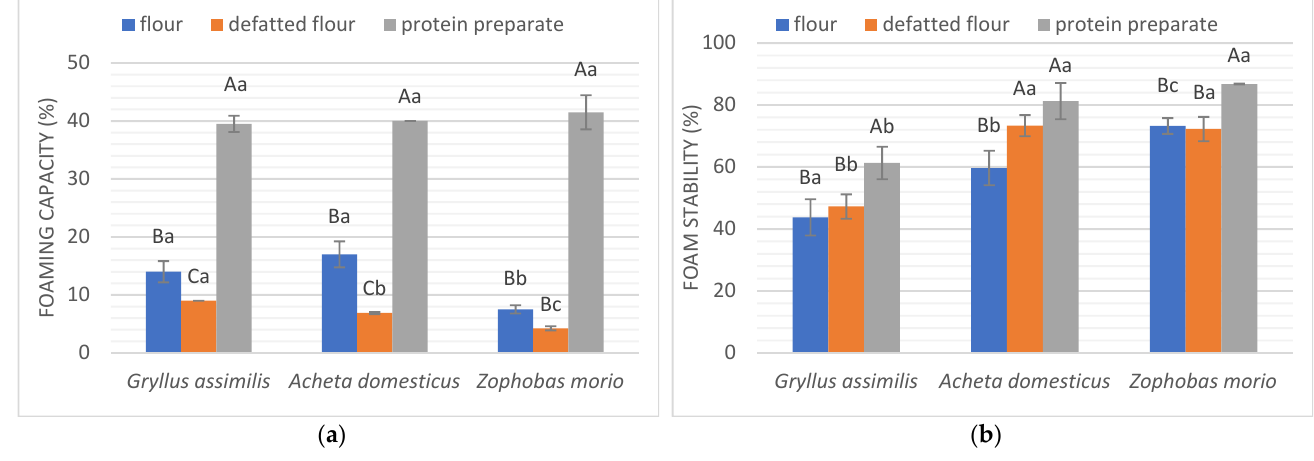
Figure 3. Foaming properties of studied insect forms. ( a ) Foaming capacity (%); ( b ) foam stability (%). Different letters in the same form of an insect (flour, defatted flour, protein preparation) indi- cate a significant difference ( p < 0.05). Different capital letters in the same insect species indicate a significant difference ( p < 0.05).